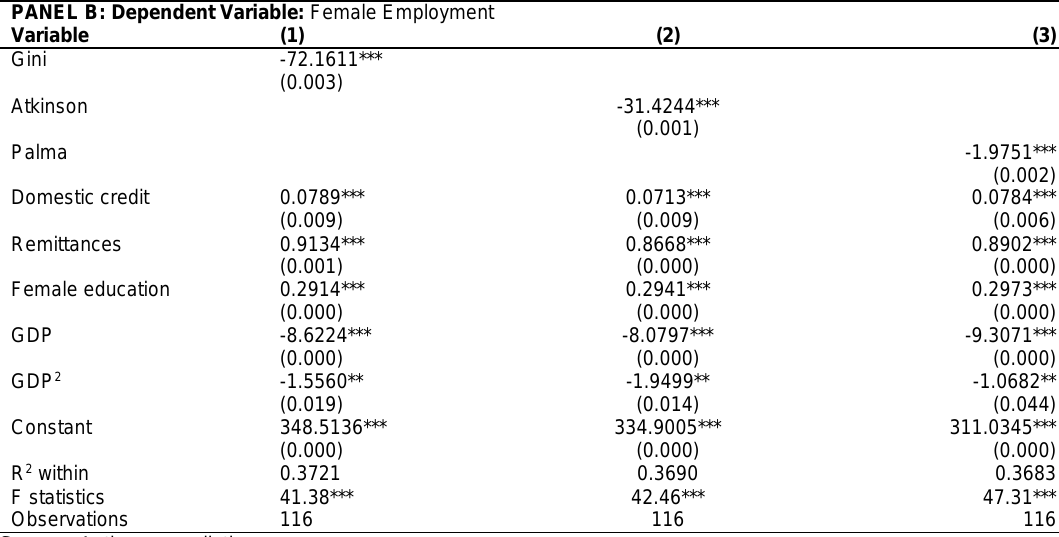
Table 4. Instrumental Variable Fixed Effects Results (2).